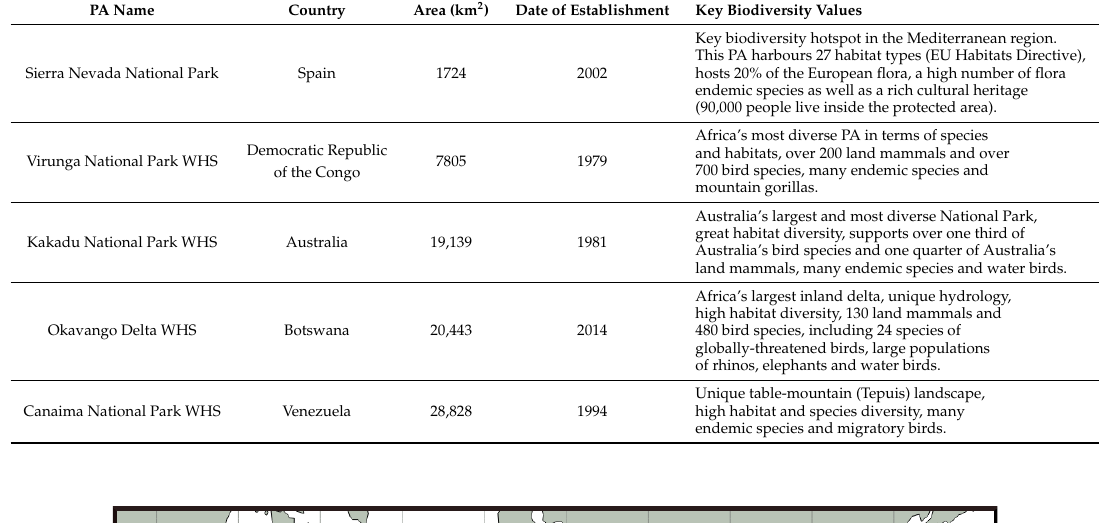
Table 1. Main characteristics of the protected areas (PA) selected for this study. WHS stands for World Heritage Site.